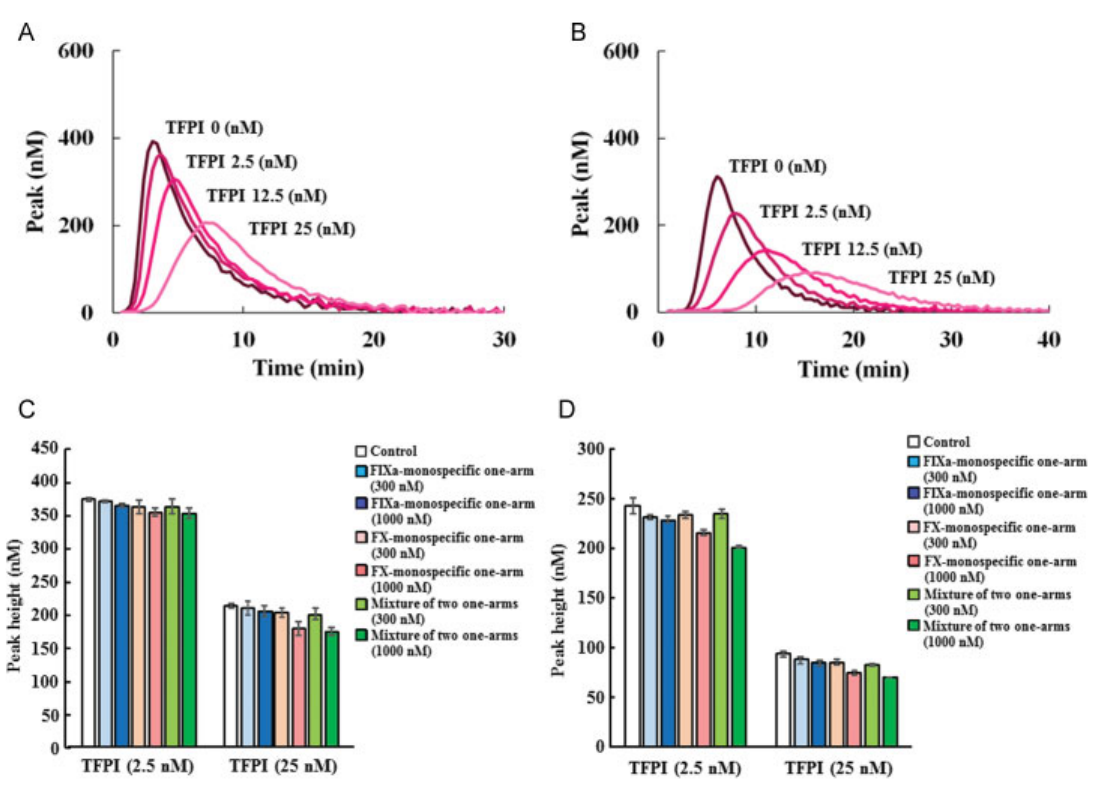
Fig. 4 Effects of TFPI and anti-FIXa and anti-FX one-armed antibodies on thrombin generation in TFPI-depleted plasma. Effects of various concentrations of TFPI onthethrombin generation parameter peak height inTFPI-depleted plasma triggered by ( A ) high concentrations of TFand ( B ) low concentrations of TF. Data were collected in triplicate and representative thrombograms are shown. Effects of various concentrations of anti-FIXa and anti-FX monospeci fi c one-armed antibodies, and mixtures of the two one-armed antibodies on the thrombin generation parameter peak height inTFPI-depleted plasma triggered by ( C ) high concentrations of TFand ( D ) low concentrations of TF in the presence of 2.5 and 25 nM of TFPI. Data are expressed as mean (cid:2) SD ( n ¼